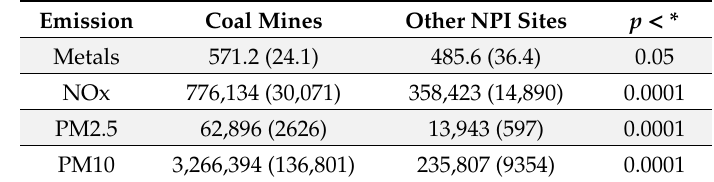
Table 4. Mean (standard error) air emissions in kg from coal mines compared to other NPI sites, Australia,